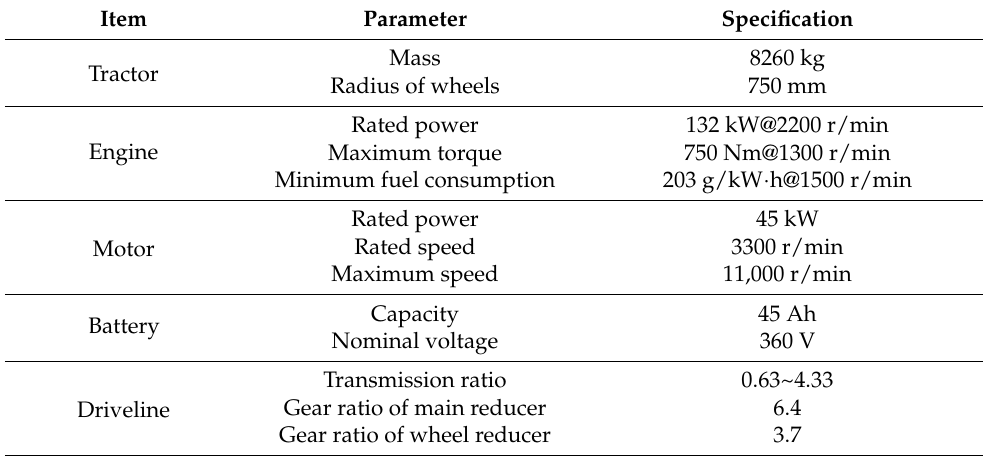
Table A1. Parameters of the tractor and key